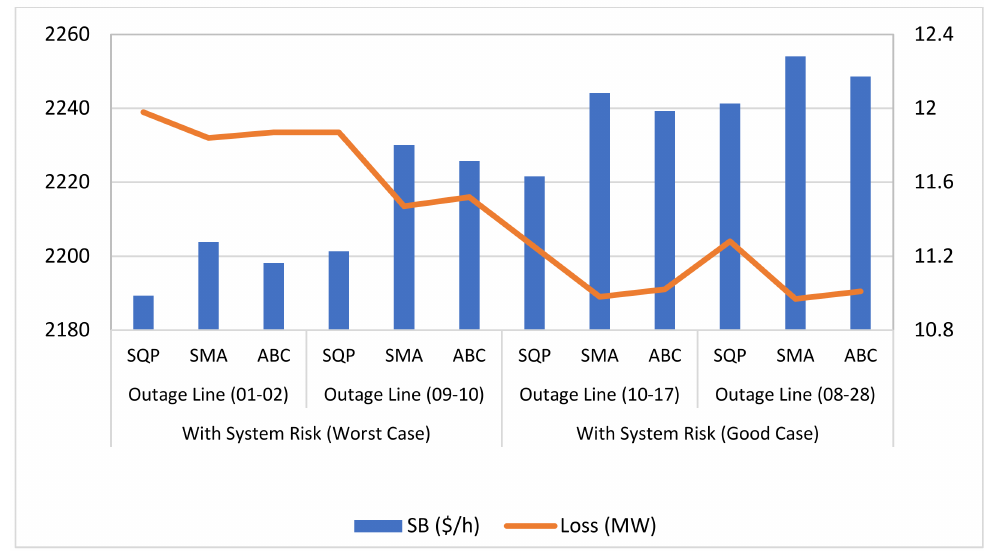
Figure 6. Social benefit and loss considering system risk under deregulated environment for IEEE 30-bus systems.